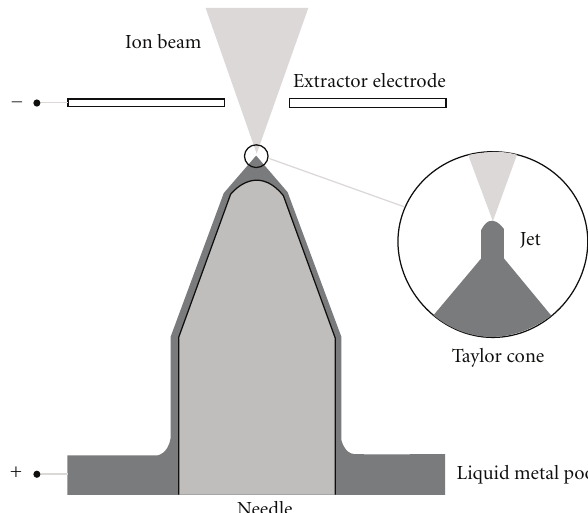
Figure 2: Concept of a needle liquid-metal-ion source.